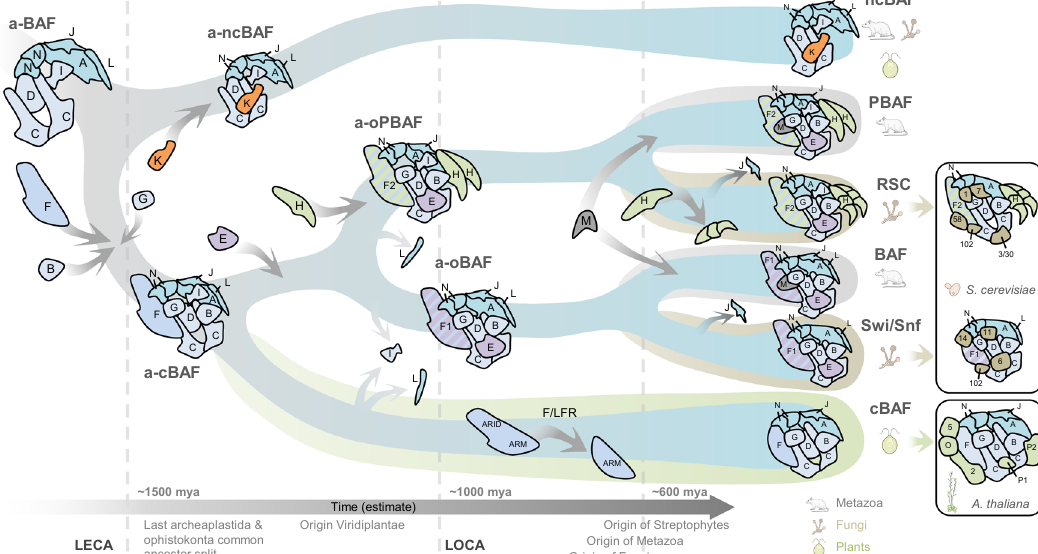
Fig. 4 Proposed evolution of the SWI/SNF family in eukaryotes. Model of the evolutionary history of the SWI/SNF complexes from a predicted ancestral complex (a-BAF) composed of an ATPase core module (subunits A, 2xN, L, and J) and a core scaffold module of subunits 2xC, D, and I. Early branching of the a-BAF into an ancestral non-canonical BAF (a-ncBAF) by the acquisition of the K subunit, and an ancestral canonical BAF (a-cBAF) by the addition of B, F, and G subunits most likely occurred in the LECA prior to the split between Archeaplastids and the lineage that gave rise to the opisthokonts. The presence of the K and I signature subunits suggests that ncBAF is present in Metazoa, Archaeplastida, and Fungi (probably lost in derived lineages as Saccharomycetes where K and I are absent). Incorporation of the E subunit into the a-cBAF gave rise to a predicted opisthokontan-type of cBAF that further diverged into the ancestral opisthokontan BAF and PBAF (a-oBAF and a-oPBAF) by the incorporation of the signature H subunit in the PBAF line, and the loss of the L and I in the a-oPBAF and a-oBAF lines, respectively. The duplication and subfunctionalization of the F subunit into the F1 and F2 types of F subunits (for a-oBAF and a-oPBAF, respectively) is also predicted to have occurred during oBAF-oPBAF emergence in the LOCA, before fungi and animals diverged. The Archaeplastid lineage retained a single cBAF that early lost the subunits I and L, and subsequently lost the ARID domain of the F subunit during Streptophyta emergence, originating the LFR type of the F subunit. The acquisition of the M subunit and the loss of the J subunit represent lineage- speci fi c events occurring after the metazoan and fungal split. A putative split of the ancient H subunit into the fungal Rsc1/2/4 subunits could have occurred after the divergence of the a-oPBAF into RSC complexes. The presence of each predicted type of complex in extant lineages is indicated, with lineage-speci fi c subunit composition speci fi ed for S. cerevisiae and A. thaliana , representing SWI/SNF complexes´ fl exibility to acquire and lose ancillary subunits. Timeline and indicated events are an estimate. A, SMARCA; B, SMARCB; C, SMARCC; D, SMARCD; E, SMARCE; F, SMARCF (including ARID1, ARID2, and LFR); G, SMARCG (including Swp82/Rsc7, Req/DPFs, and TPFs); H, SMARCH; I, SMARCI; J, SMARCJ; K, SMARCK; L, SMARCL; N, SMARCN (including Actin and Actin-related proteins); 58, Rsc58; 3/30, Rsc3/30; 7, Lbd7; 6, Snf6; 11, Snf11; 102, Rtt102; 1, Htl1; 2, SHH2; P1, PSA1; P2, PSA2; 5, BRD5; O, subunits. Interestingly, structural analyses have shown that DPF2